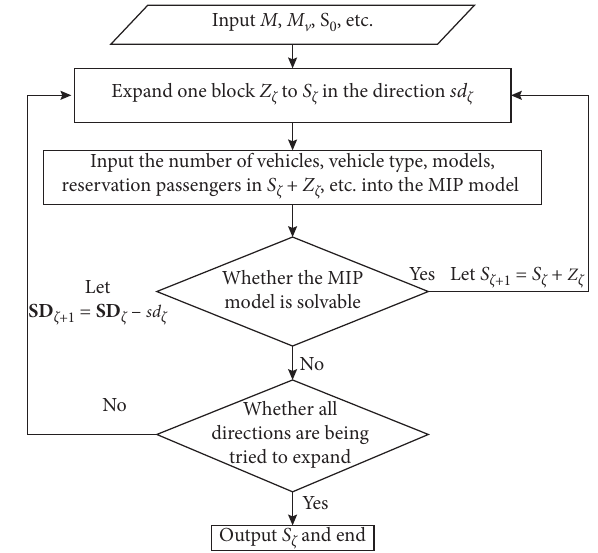
Figure 5: The optimization process of service